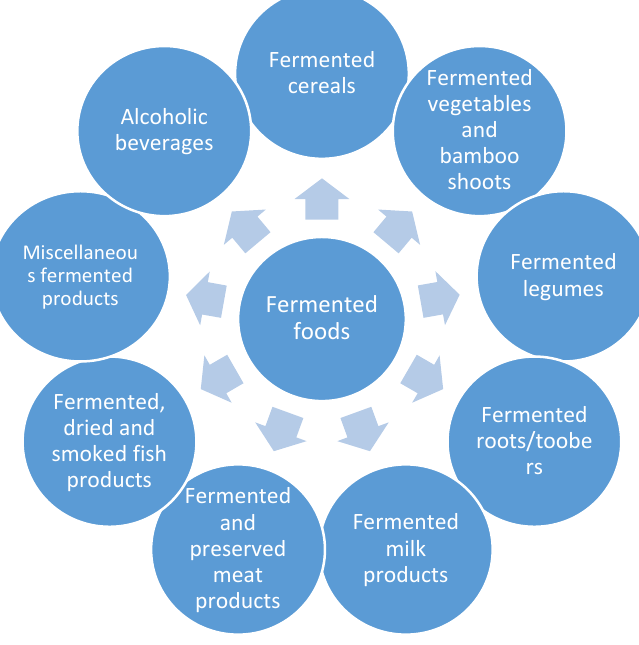
Figure 1. Types of fermented foods [8,9].